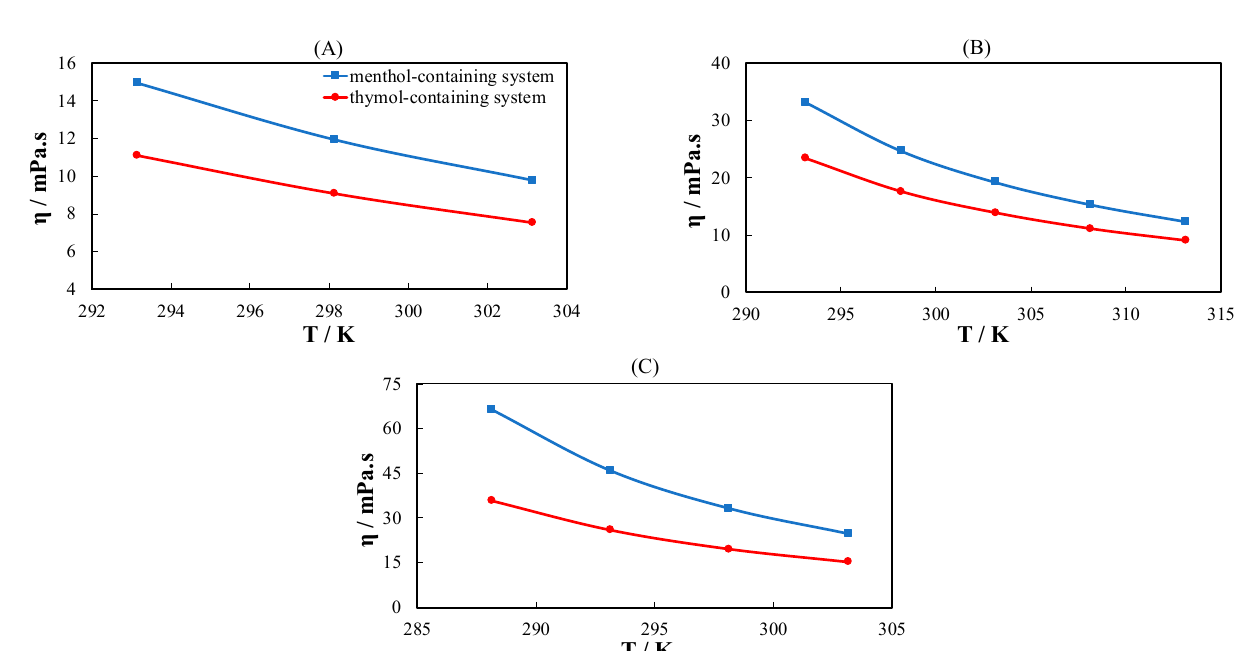
Figure 5. Viscosity of ideal eutectic systems containing either L -menthol or thymol with ( A ) caprylic acid (linear), ( B ) 3-phenylpropionic acid (phenyl), or ( C ) cyclohexanecarboxylic acid (cyclohexyl) with an equimolar ratio as a function of temperature.